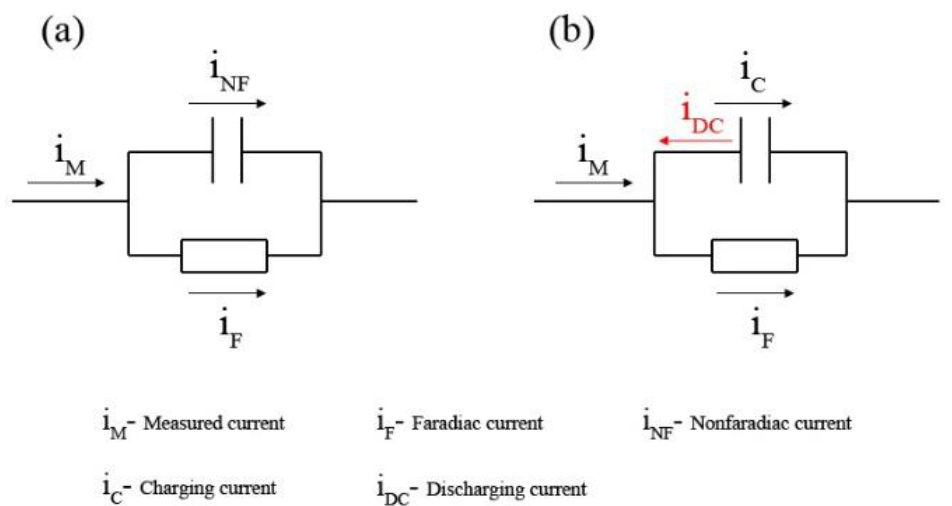
Figure 9. Diagram of equivalent electric circuits of electrode-applied currents ( a ) charging current, ( b ) the discharging current.